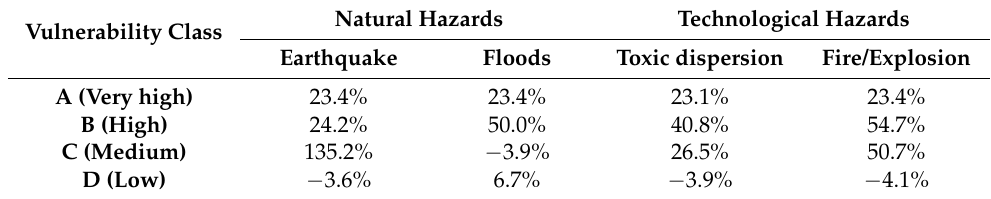
Table 2. Summary of vulnerability level variation between 2006 and 2018 in Cluj-Napoca FUA.